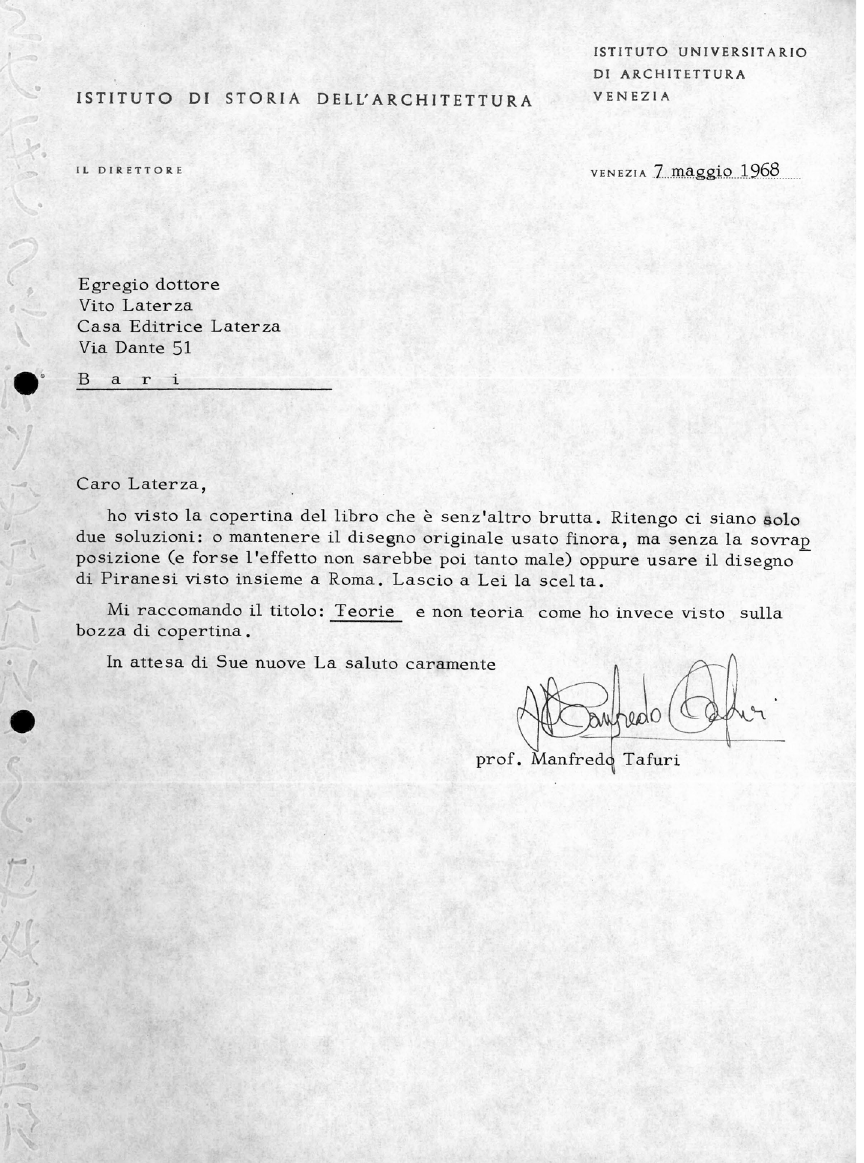
Fig. 14 Manfredo Tafuri, typewritten on headed paper and signed letter to Vito Laterza. Venice, 7 May 1968 (Source and credits: Archivio Autori Editori Laterza – per gentile concessione / Archivio Autori Editori Laterza – with kind